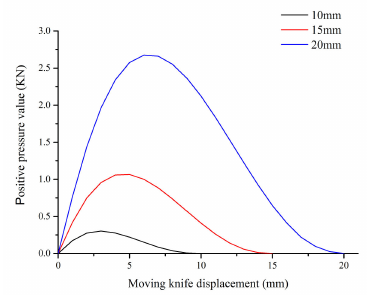
Figure 15. Force diagram of shear theory.